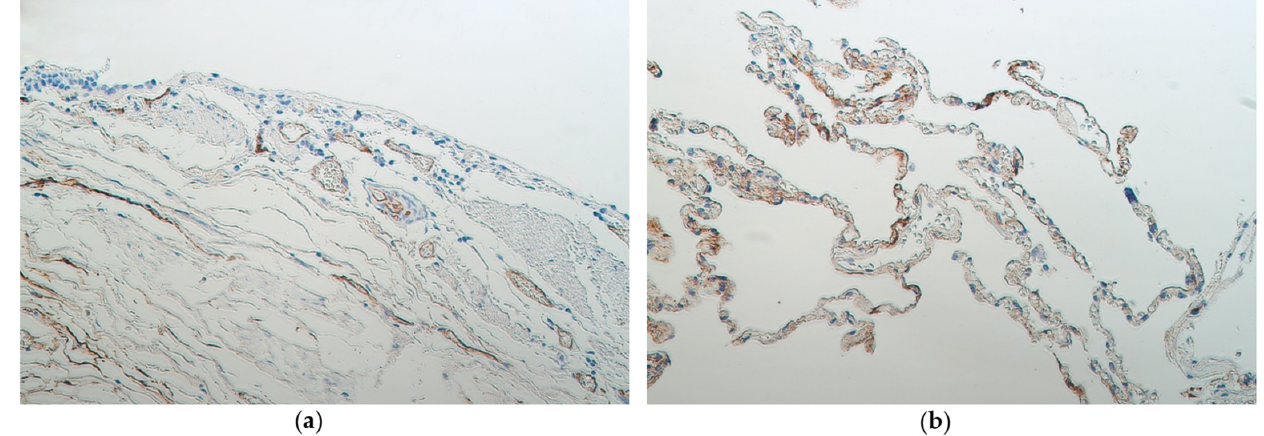
Figure 6. ( a ) Few to moderate number of CD34-positive subepithelial blood vessels in a 95-year-old female with partially detached non-changed bronchial epithelium. CD34 IMH, X200. ( b ) Few to moderate CD34-positive alveolar blood vessels in lung tissue of 86-year-old male with metaplastic bronchial epithelium. CD34 IMH, X200.